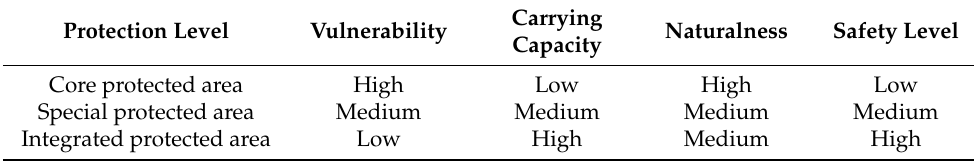
Table 2. The three-tier protection zoning system of China’s geoparks. Carrying Naturalness Safety Level Protection Level Vulnerability Capacity Core protected area High Low High Low Special protected area Medium Medium Medium Medium Integrated protected area Low High Medium High